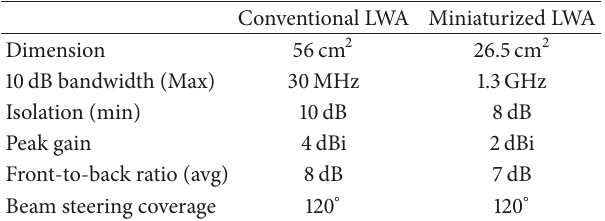
Table 2: Comparison between conventional and miniaturized